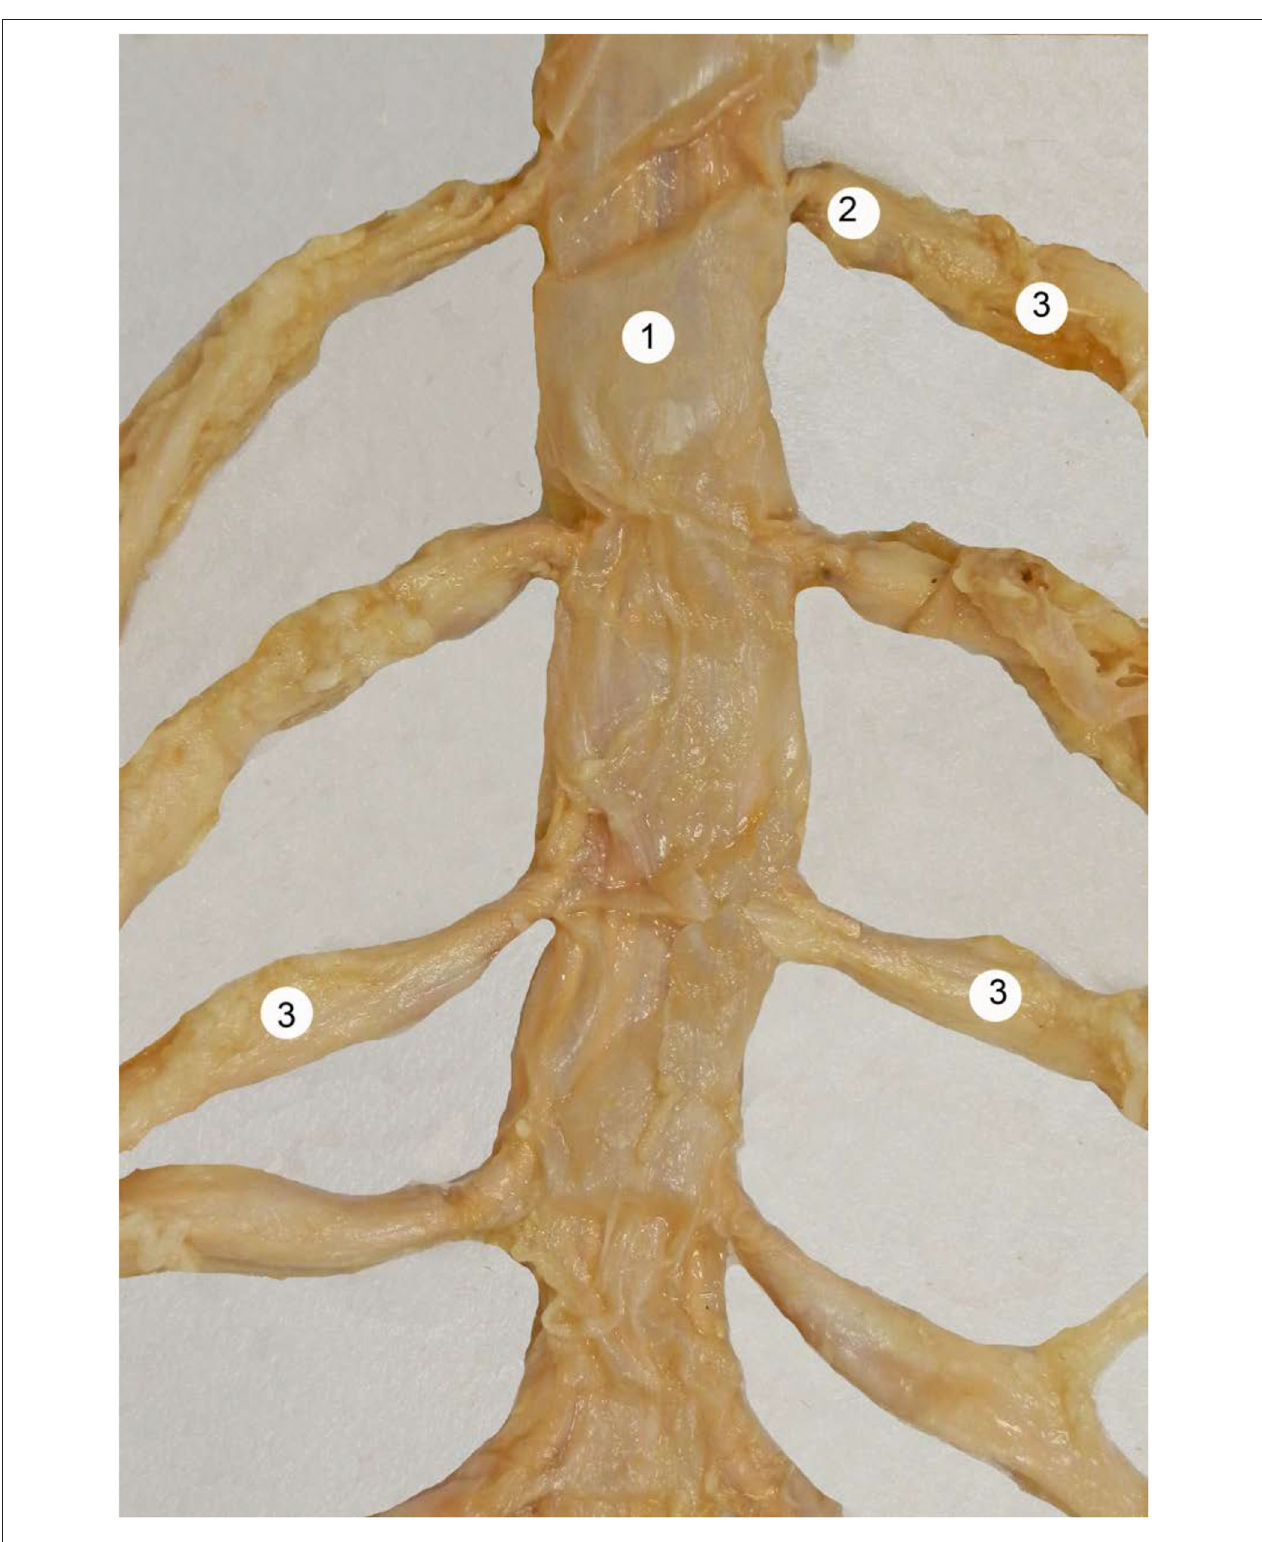
FIGURE 1 | Human dural sac at the lumbar region. 1 = dural sac, 2 = nerve root cuff, 3 = dorsal root ganglia. With permission of Dr. Miguel A. Reina.